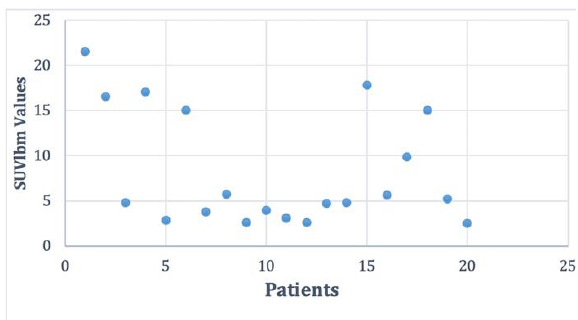
Figure 2. The distribution of the SUVlbm (standardized uptake value lean body mass) Max values in the studied cohort.